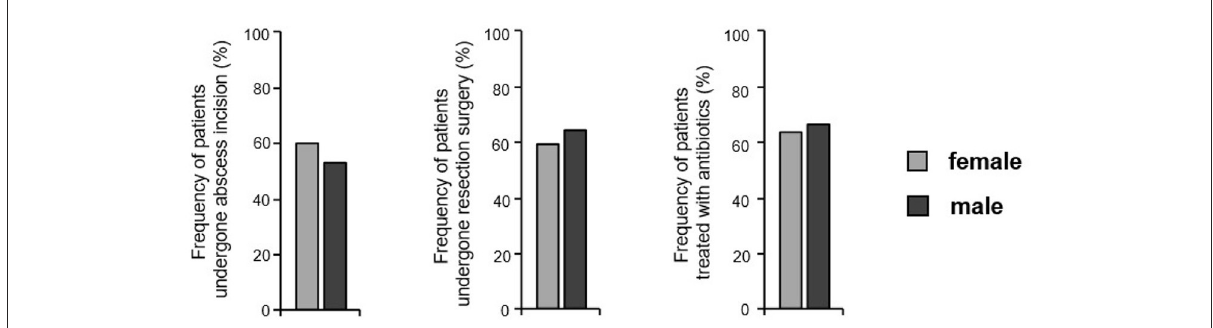
FIGURE5 Treatments previously performed in both sexes. The frequency of HS patients reporting previous abscess incision, wide skin resection, and antibiotic treatment is given ( n = 445, female: 268, male: 177). Significance of differences was assessed by the Chi-square test.